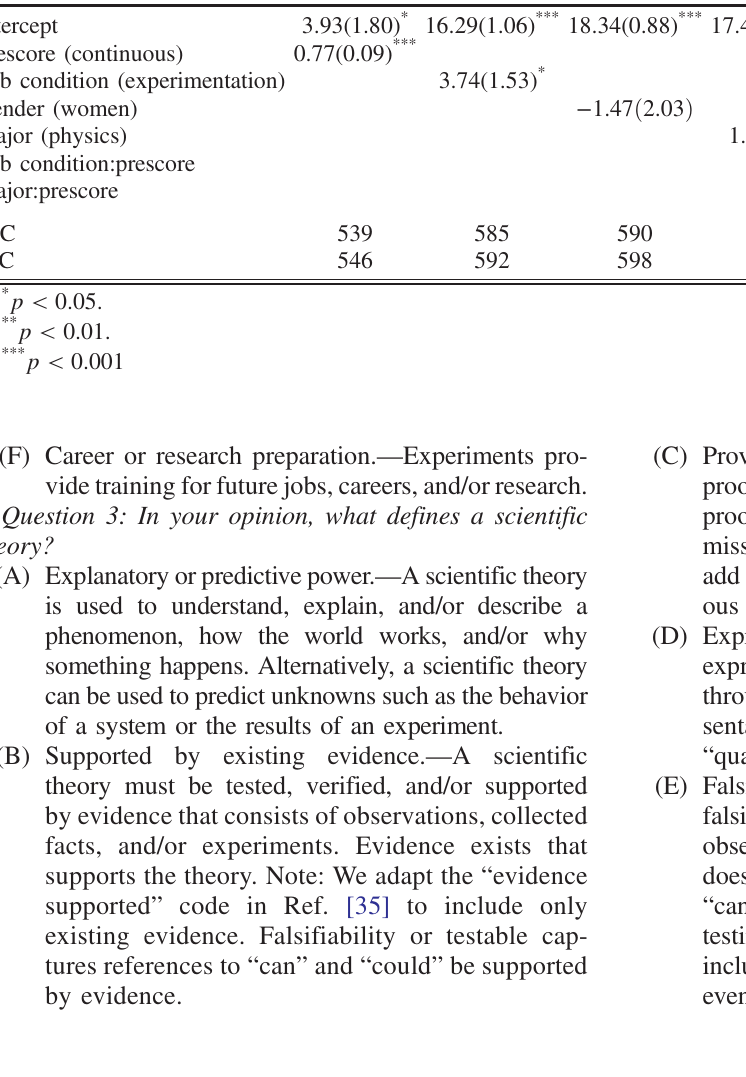
TABLE XIII. Descriptive statistics of all students ’ scores and of the subset of students ’ scores that are included in the E-CLASS analyses before and after lab instruction. Means are reported with standard deviations, and medians are reported with median absolute deviations.